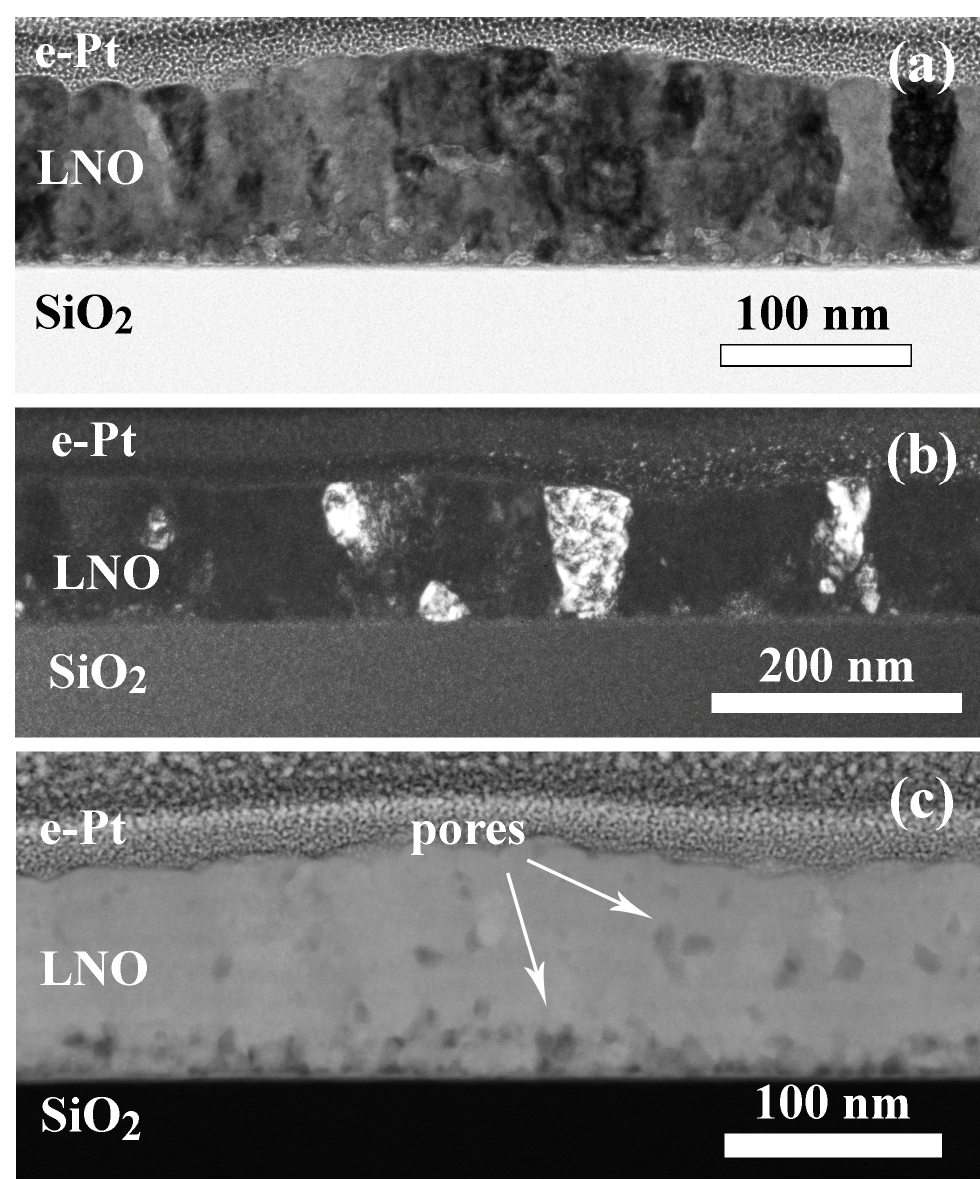
Figure 6. Structure of LNO ‐ cryst ‐ 7 min sample: BF TEM image ( a ), DF TEM image ( b ), and HAADF STEM image ( c ).